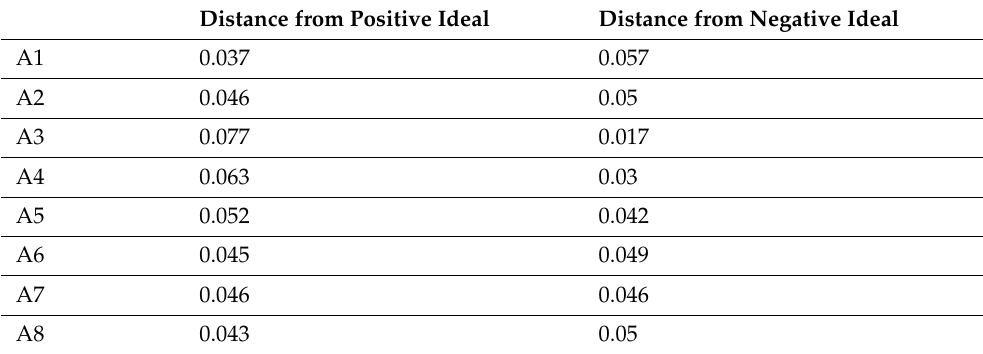
Table 7. Distance from positive and negative ideal